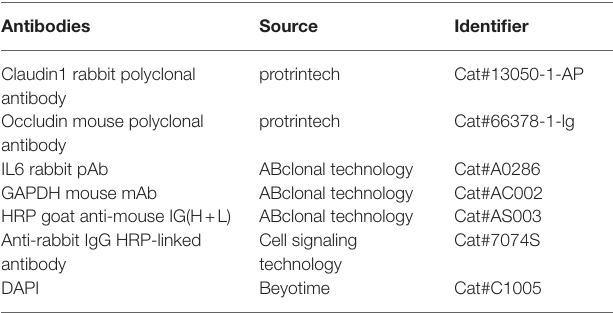
TABLE 2 | The antibodies used in WB and IFA analysis.